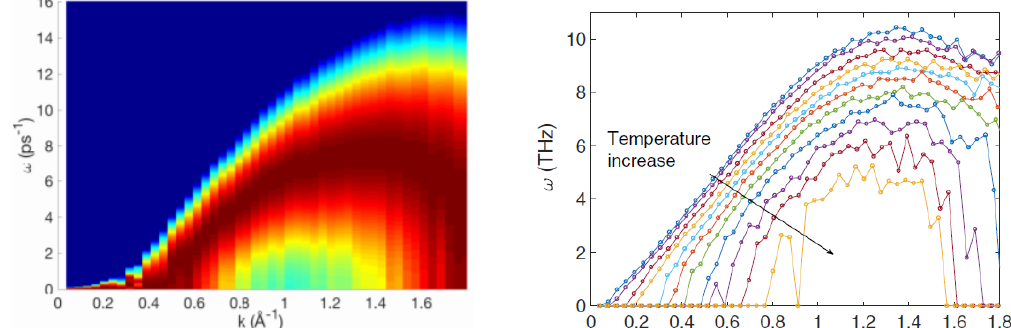
Figure 1 . Molecular dynamics simulations for supercritical Ar and CO2 between 200 K and 500 K. The simulations show the presence of a k-gap in the transverse phonons dispersion relation. Figures taken from